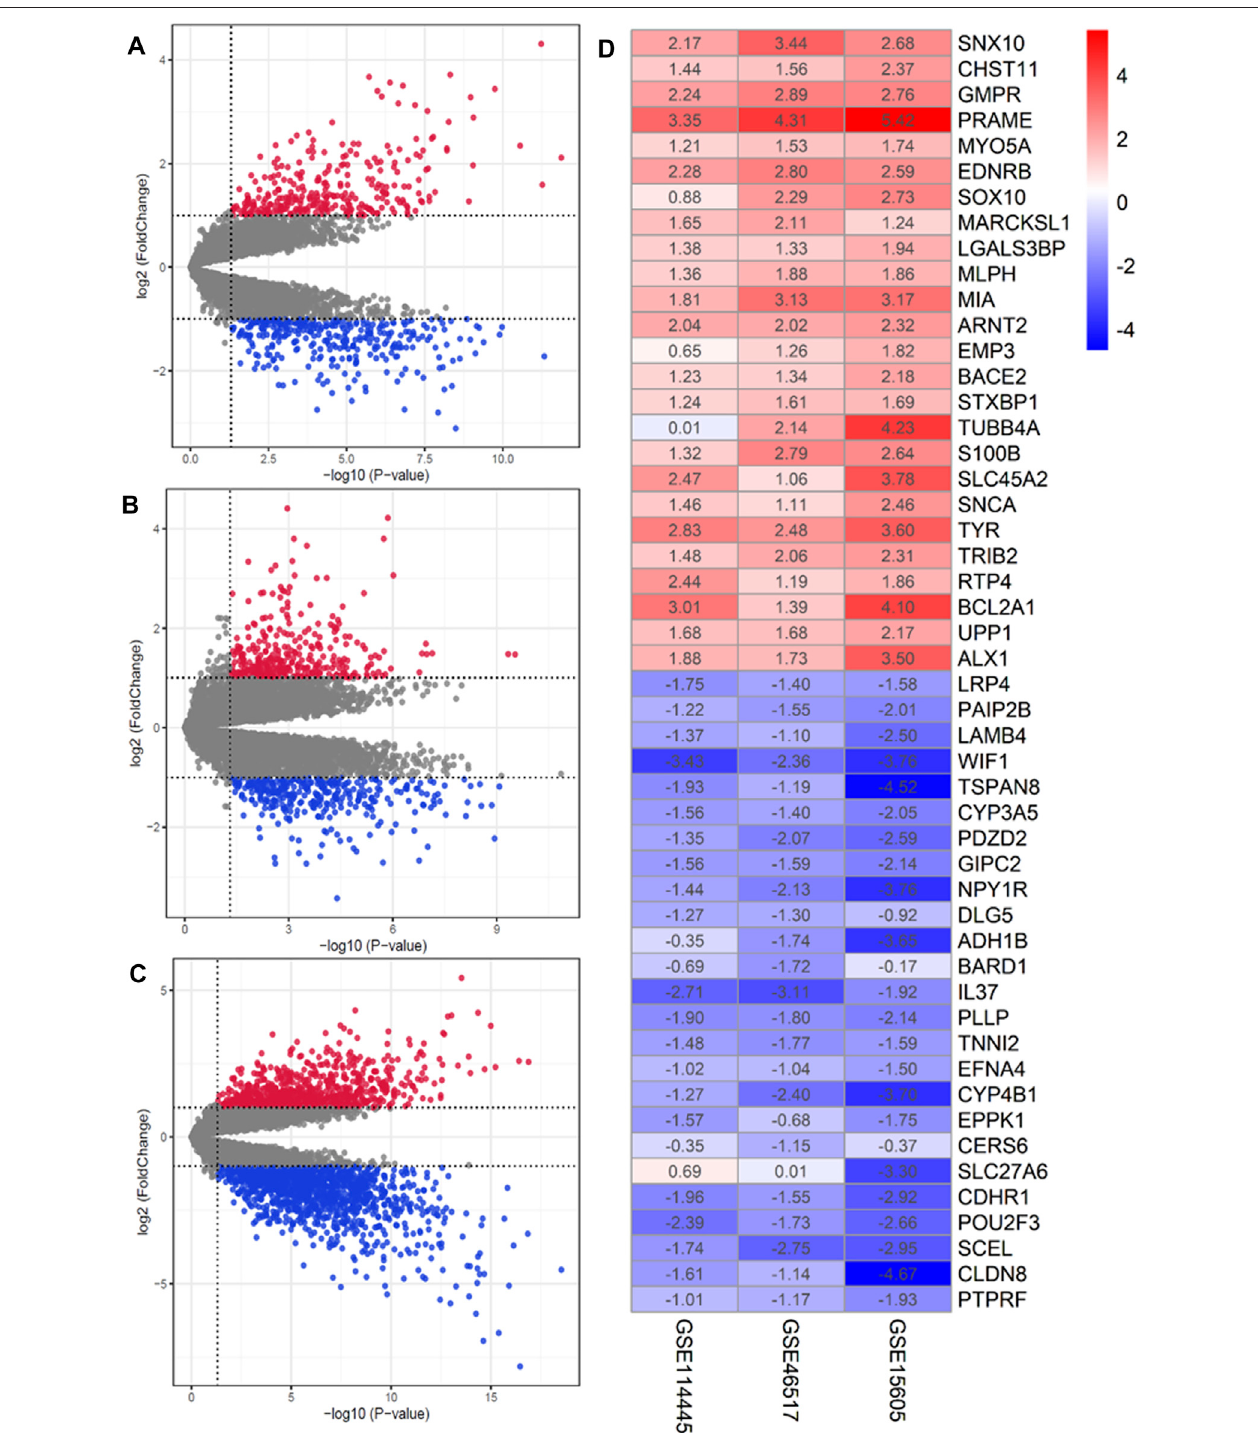
FIGURE 2 | Identi fi cation of DEGs in GEO database. (A – C) Volcano plot of the DEGs in GSE15605, GSE46517 and GSE114445. Red and green indicate upregulated and downregulated genes ( p < 0.05, LogFC ≥ 1 or ≤ − 1), respectively. (D) Heatmap of the top 25 up- and down-regulated genes in the RRA analysis. The abscissa is the geo ID, and the ordinate is the gene name. Red represents logFC > 0, blue represents logFC < 0, and the values in the box represent the logFC values.